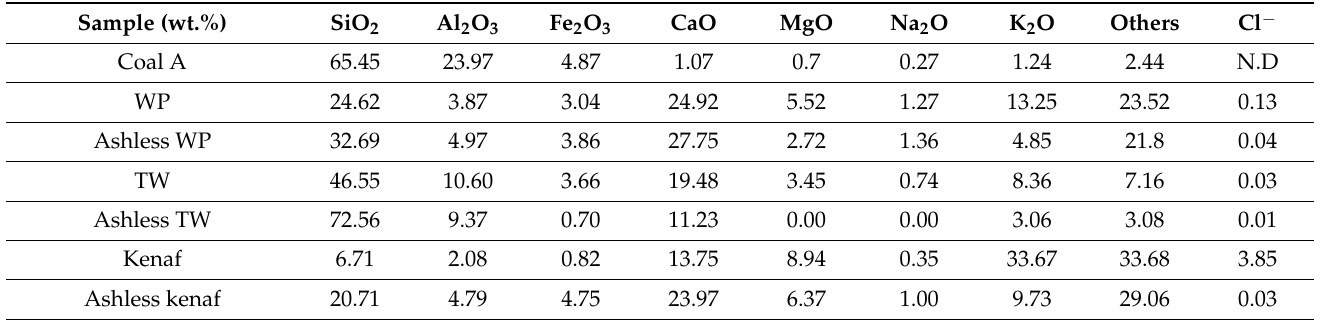
Table 2. Ash composition rate of coal and raw biomass om ALB